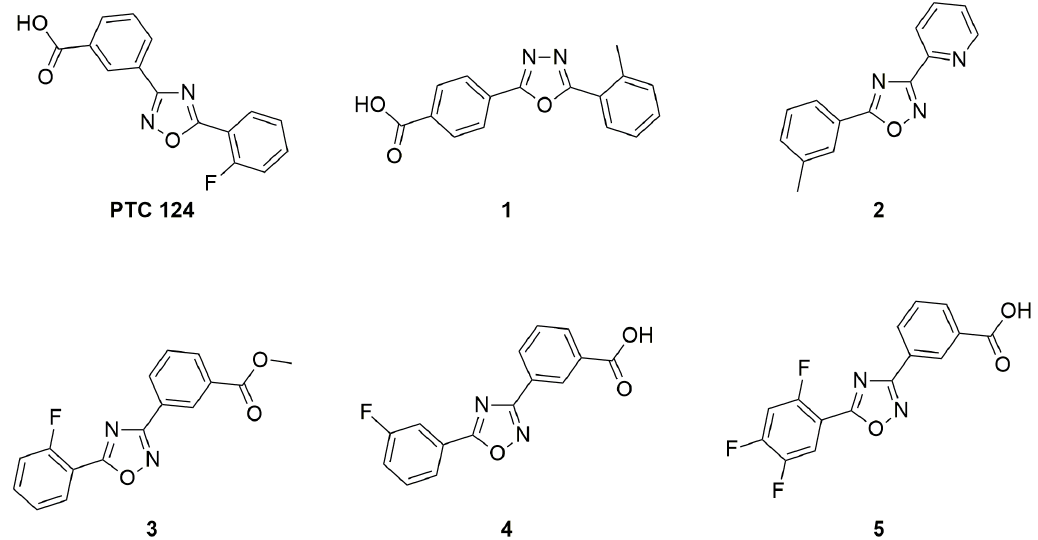
® ) and its most active